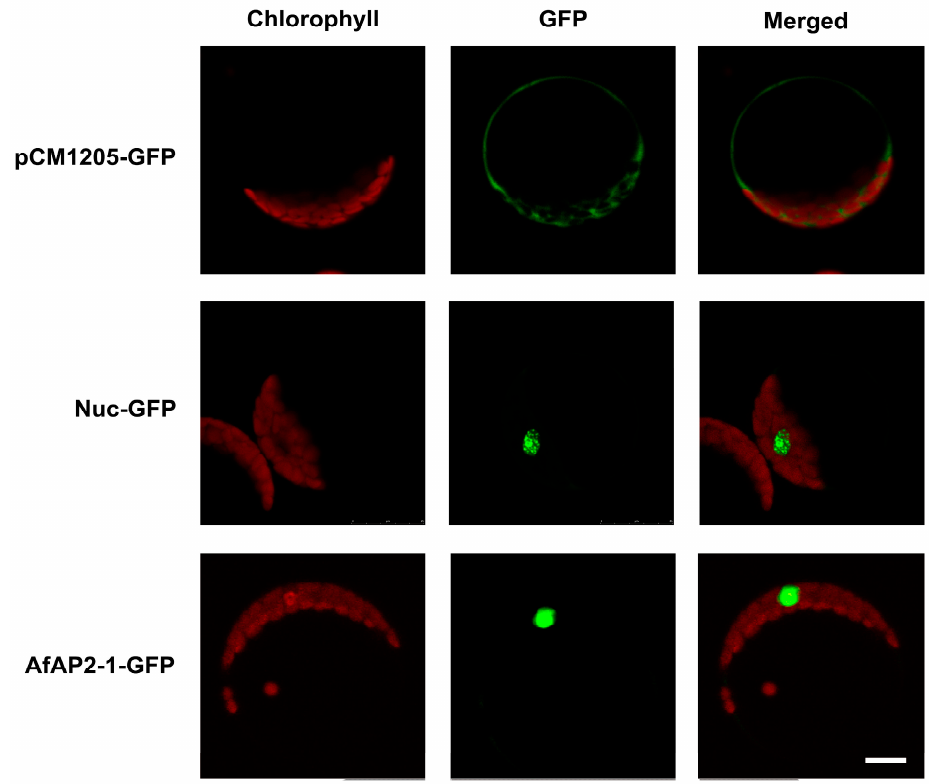
Figure 5. Subcellular localization of AfAP2-1-GFP fusion protein. Green fluorescence indicates GFP, and red fluorescence shows chloroplast auto-fluorescence. pCM1205-GFP: control lacking the transit peptide; Nuc-GFP: control with the nuclear localization signal of fibrillarin. AfAP2-1-GFP: GFP signals from the AfAP2-1-GFP fusion protein. The fluorescence signals were visualized using confocal laser scanning microscopy. Scale bar: 5 µm.